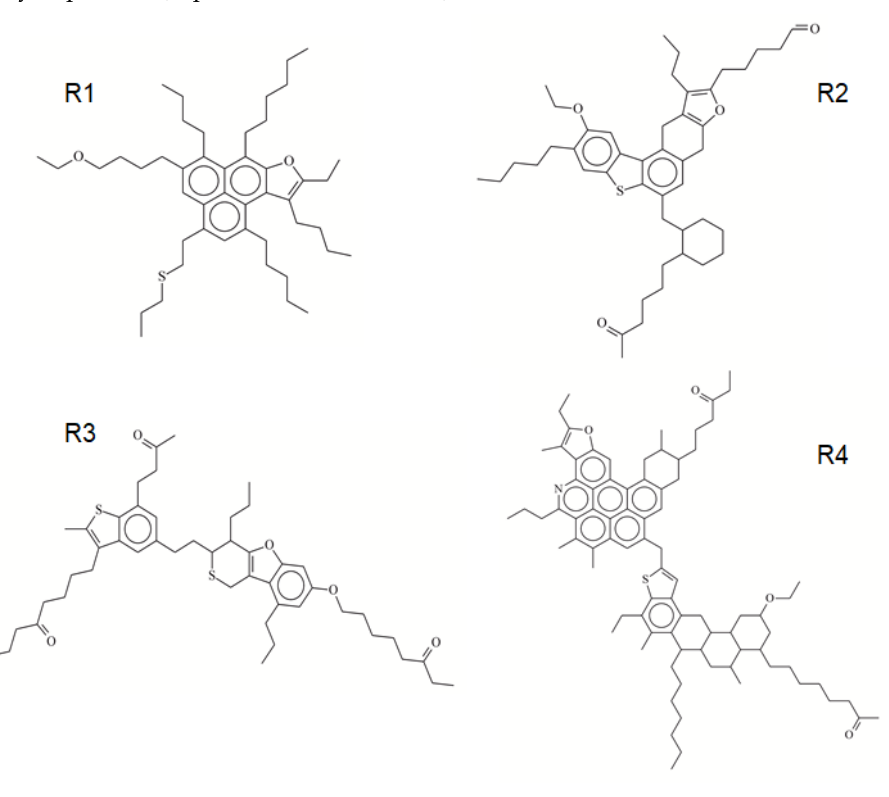
Figure 7. Spatial structures of the resin fractions of the catalytic aquathermolysis product with a hydrogen donor (6 h).